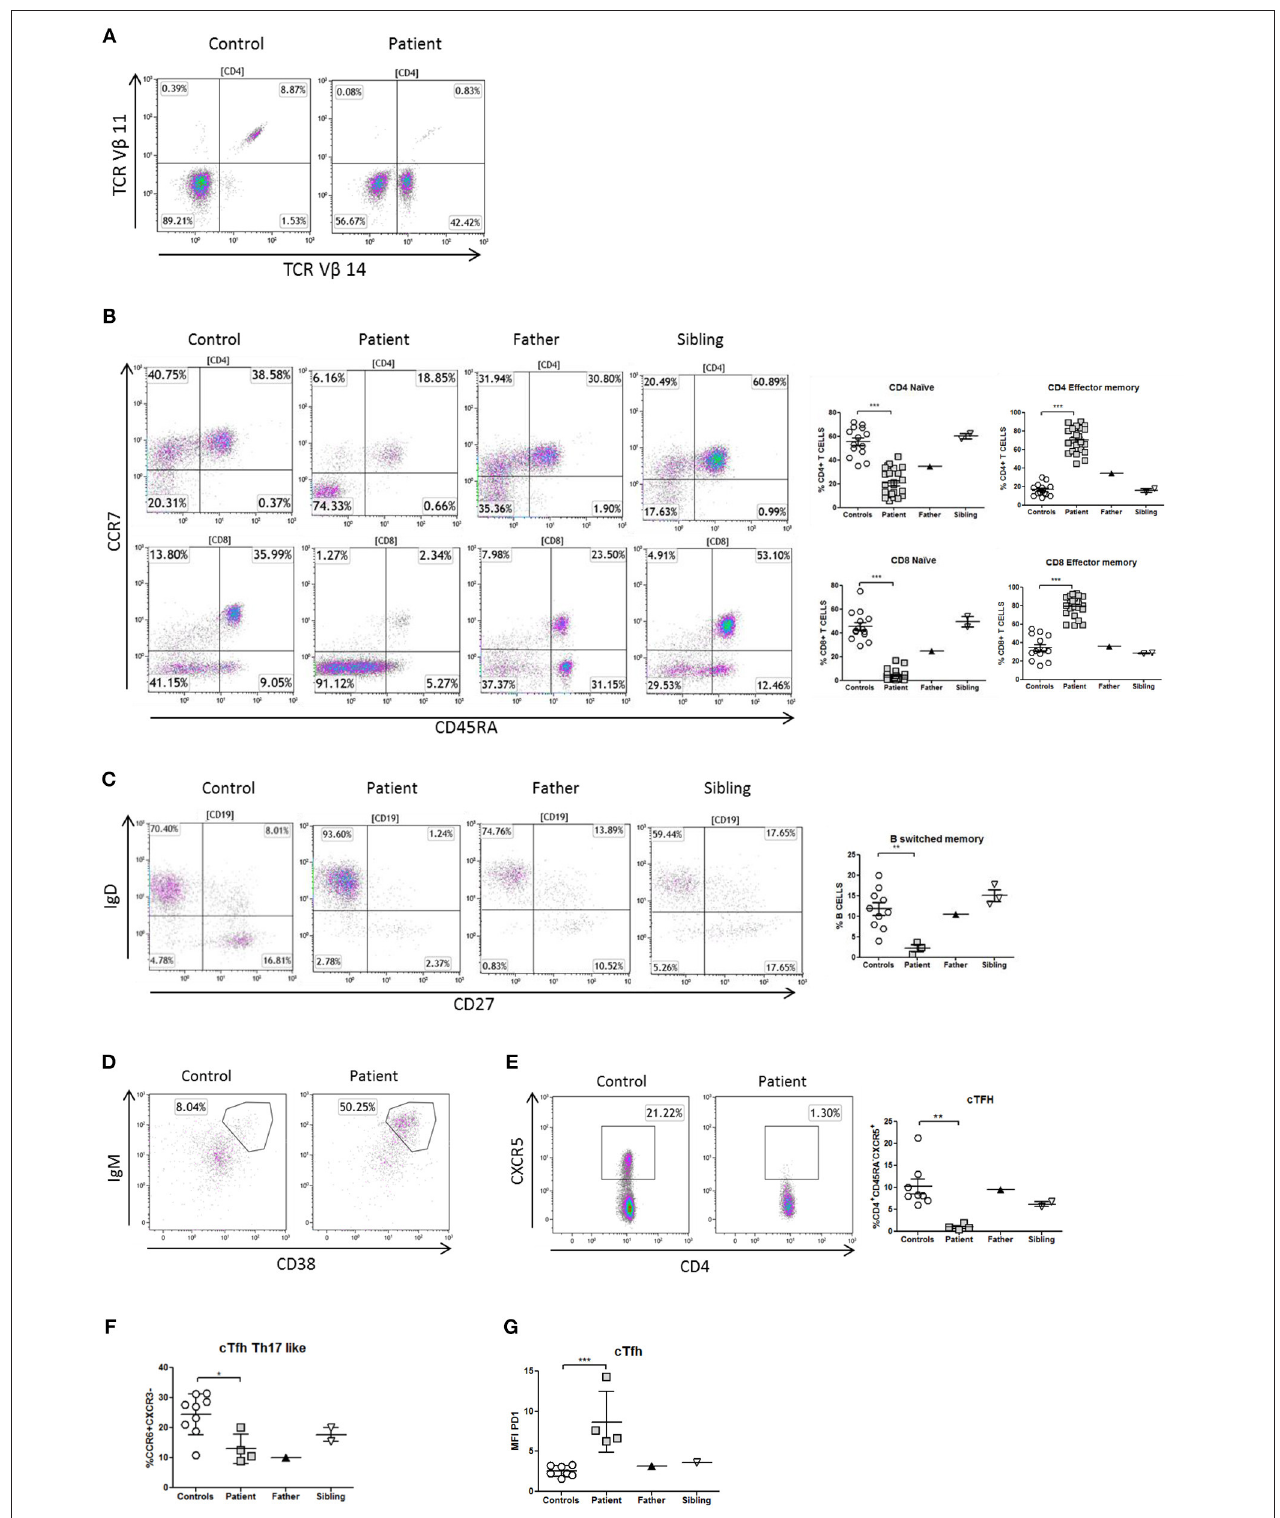
FIGURE 3 | Immunophenotype of T- and B-cells in a patient with NF- κ B1 deficiency. (A) TCRV β repertoire: the patient showed an expansion of the family CD3 + TCR αβ + V β 14 + compared to healthy control; (B) Decrease naïve (CCR7 + CD45RA + ) and high levels of T-effector memory phenotype (CCR7-CD45RA-)